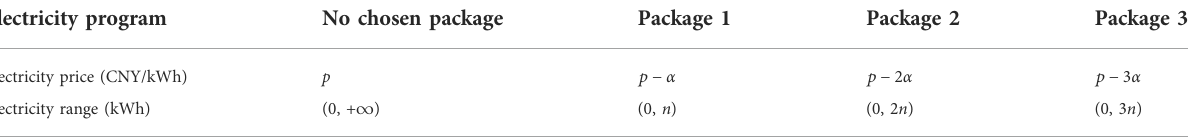
TABLE 1 The settings of each package plan. Electricity program Electricity price (CNY/kWh) Electricity range